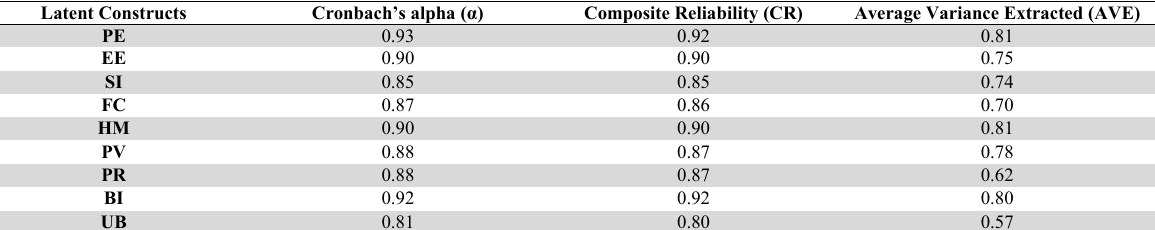
Construct reliability Latent Constructs